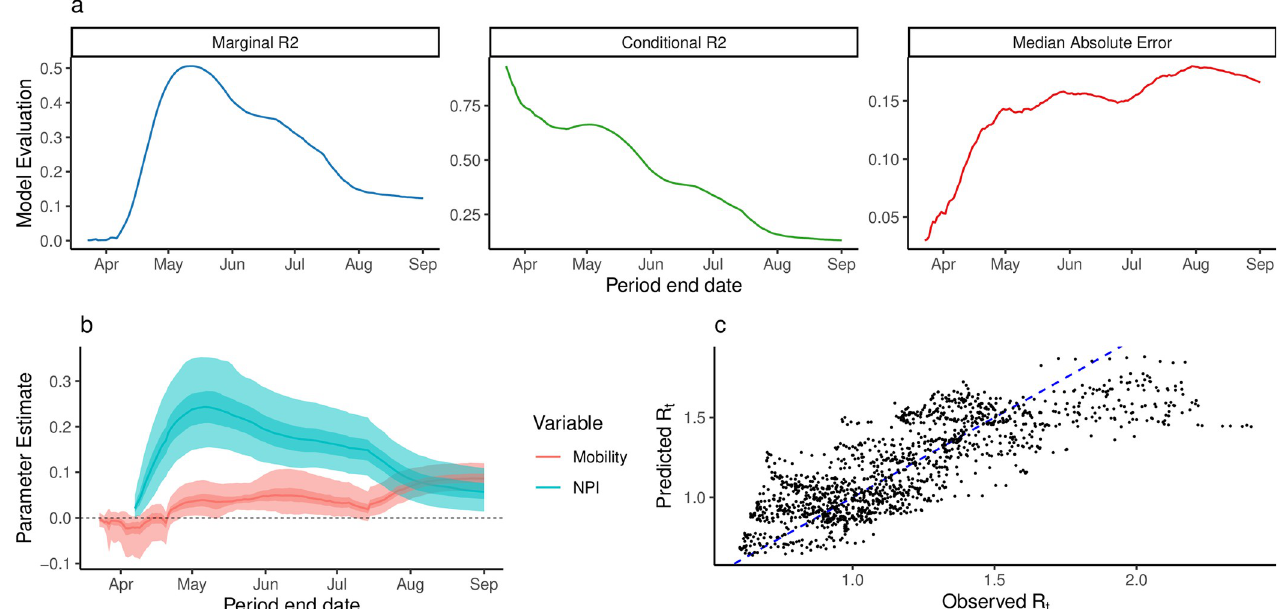
Fig 4. Statistical analysis of R t . a) The marginal R 2 , Conditional R2, and median absolute error of the multilevel model trained on varying-length periods through time. b) Parameter estimates of association of Rt with NPI and Mobility. Estimates shown with 50% and 95% bootstrap confidence intervals. c) Observed vs Predicted Rt for the model trained between 12th March and 12th May, 2020. Diagonal where x = y shown as blue dashed line.